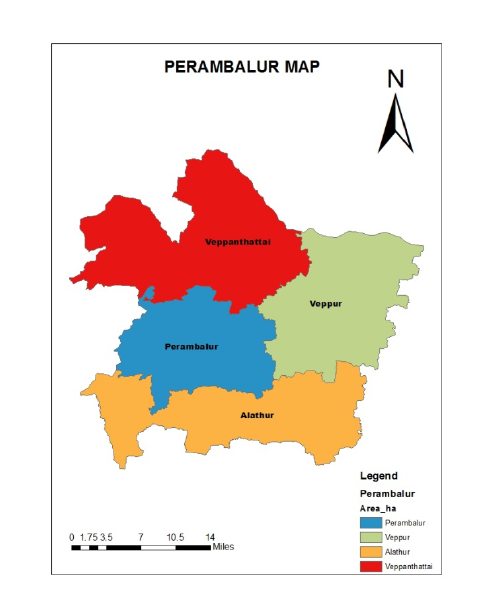
Figure 1. Map of the Study